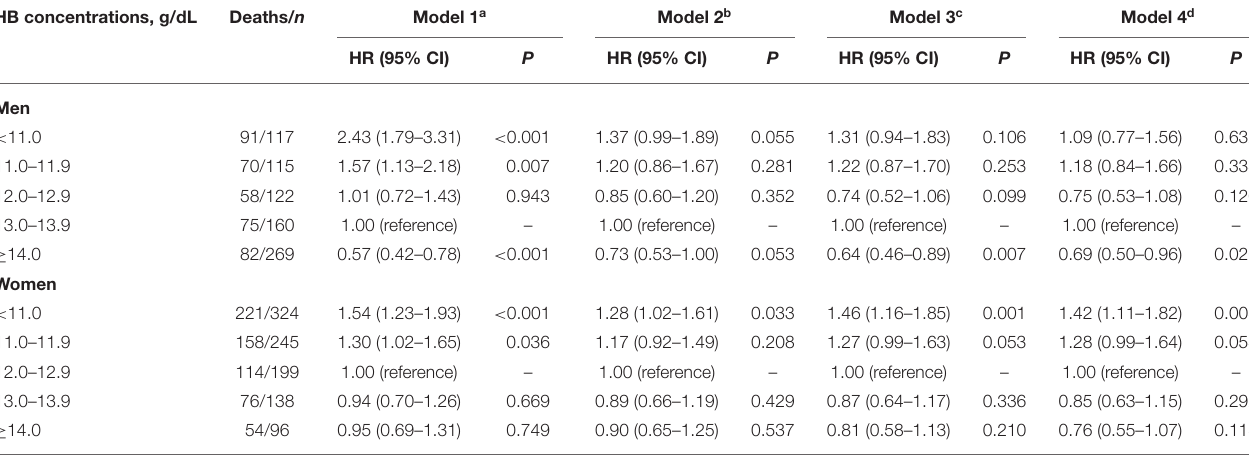
TABLE 3 | HRs (95% CI) for all-cause mortality according to HB concentrations among the older adults form Chinese longevity regions by sex. HB concentrations, g/dL Deaths/ n Model 1 a Model 2